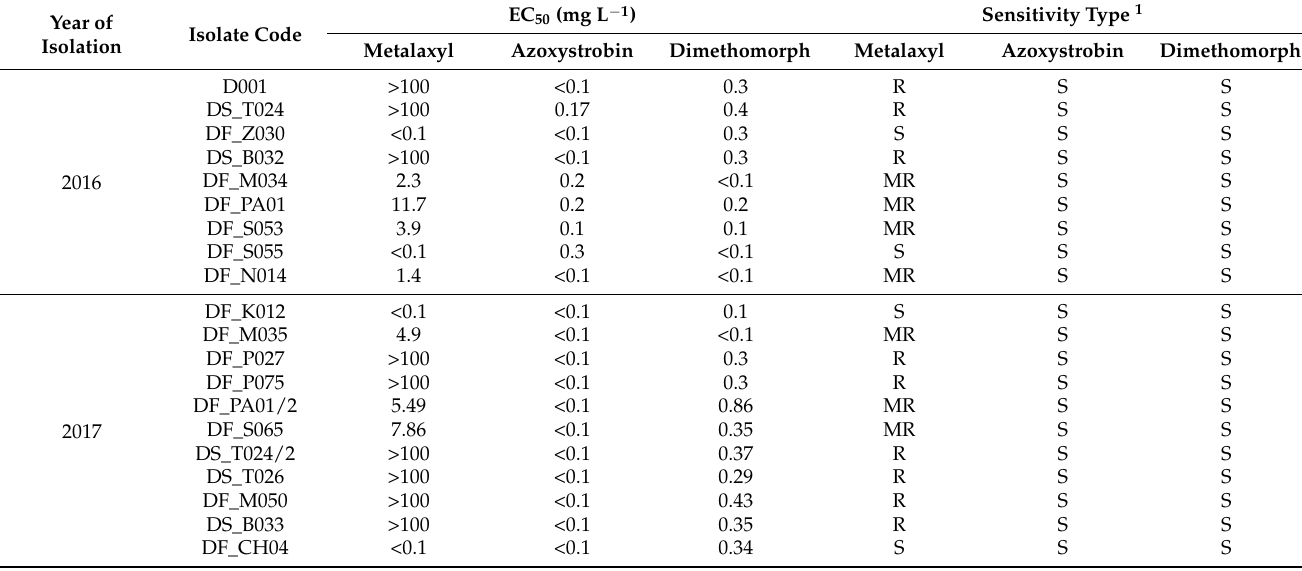
Table 2. Sensitivity of Phytophthora isolates to metalaxyl, azoxystrobin, and dimethomorph on clarified V8 juice agar. Year of Isolate Isolation